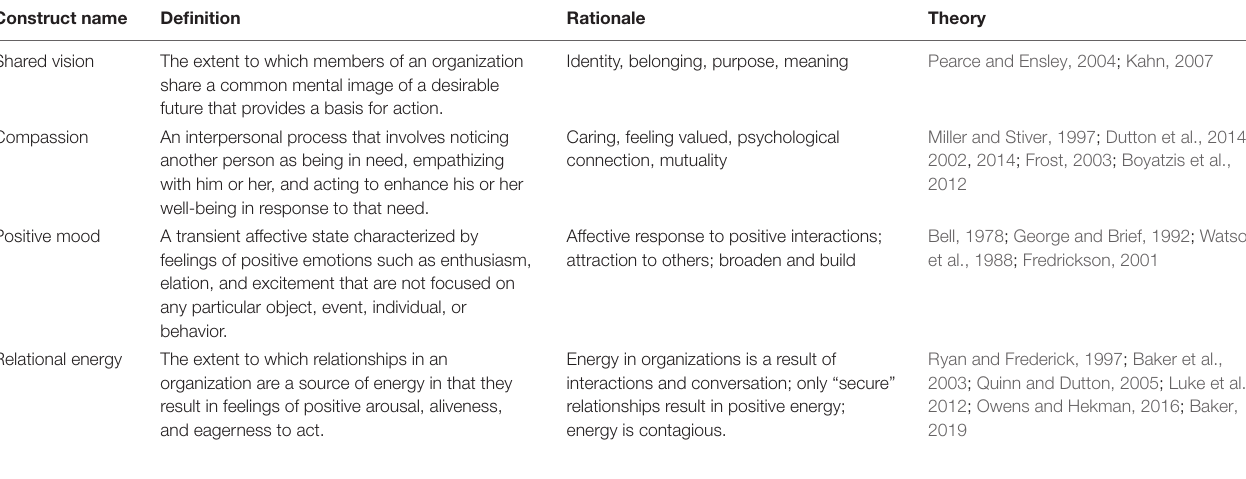
TABLE 1 | Summary of operational construct of relational